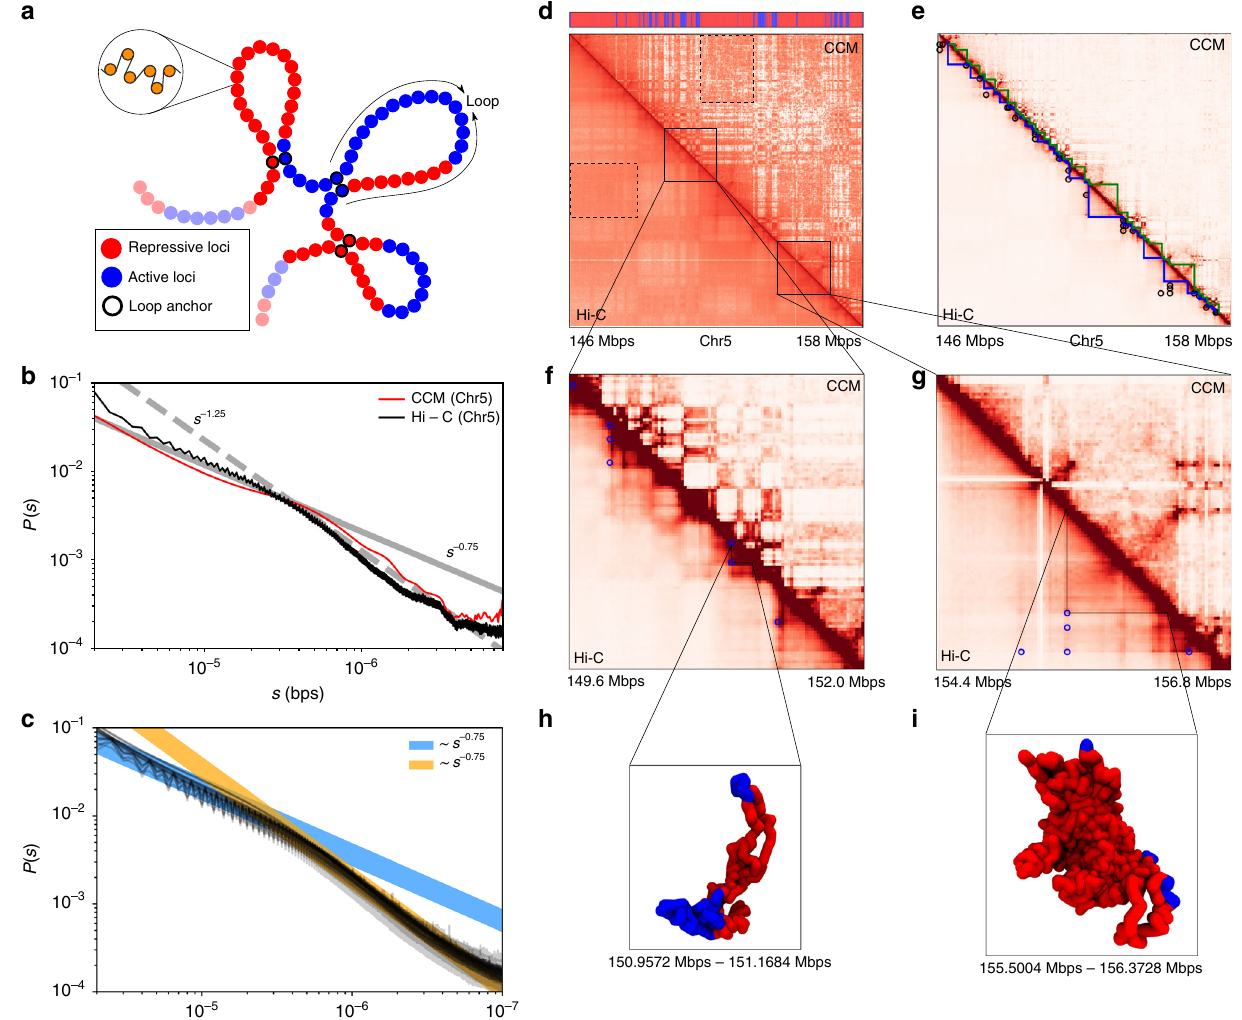
Fig. 1 Comparison between the simulated contact map and the Hi-C contact map. a A sketch of the chromosome copolymer model (CCM). Each bead represents 1200 base pairs (representing roughly six nucleosomes connected by linker DNAs). Blue (red) corresponds to active (repressive) loci. The examples of three pairs of loop anchors (in this cartoon) are marked by beads with black boundaries. b Comparison between experimental data 5 (black) and simulated P ( s ). Dashed and solid lines are plots of s − 1.25 and s − 0.75 , respectively. The crossover point between the two scaling regimes at s * ~ 3 × 10 5 bps is noticeable in both the experimental and simulated results. c Experimental contact probability P ( s ) for the 23 human interphase chromosomes calculated from the Hi-C data in ref. 5 Each black curve, all of which almost superimpose on each other, corresponds to one chromosome. Blue and orange lines are guides to the eye showing two scaling regimes. d Comparison of the contact maps inferred from Hi-C experiment 5 (lower triangle) and obtained from simulations (upper triangle) results. For easier visualization, the values of the contact probability are converted to a log 2 scale. The bar above the map marks the epigenetic states with blue (red) representing active (repressive) loci. The dashed black box is an example of a compartment. Such compartment-like structures emerge due to contacts between loci separated by large genomic distances, which gives rise to spatial order in the organized chromosome. e Illustration of topologically associated domains (TADs). The blue and green triangles are from experiments and simulations, respectively. The black circles mark the positions of loops detected from experiment data, which are formed by two CTCF motifs. f The zoom in of the diagonal region for the chromosome segment between 149.6 and 152.0 Mbps. The blue circle marks the positions of CTCF loops found in the experiment 5 . g Same as f except for 154.4 – 156.8 Mbps. h , i Snapshots of two TADs, marked by the black triangles in f and g ,